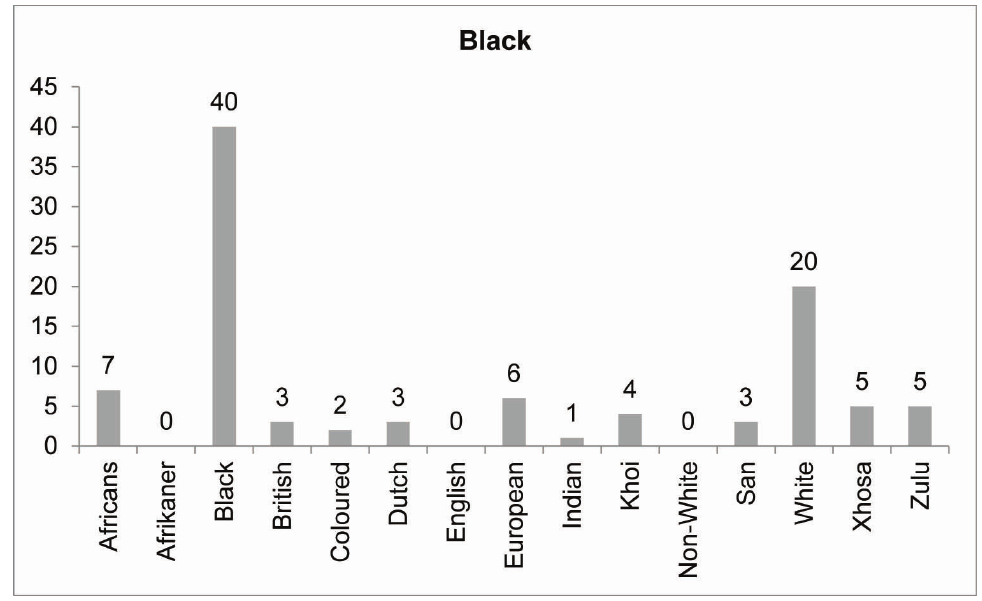
Figure 5: Races/ethnicgroupsmentionedmorethantentimesinblackstudents’narrative accounts